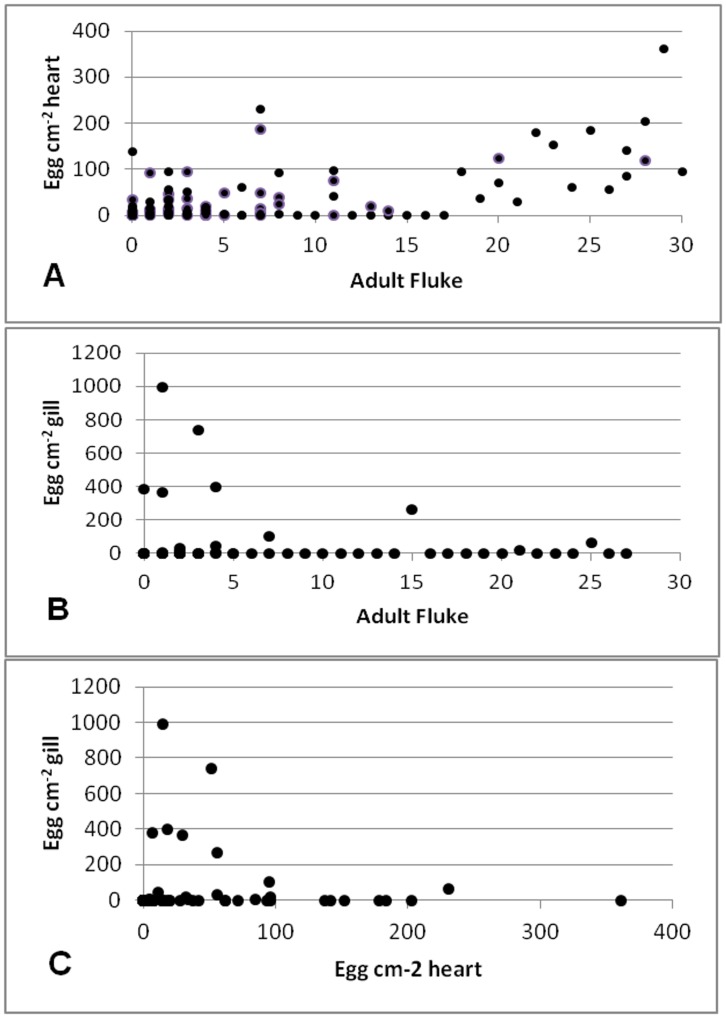
Correlation between (A) the number of adults and eggs in the heart, Spearman’s rho = 0.550, df = 184, p<0.001; (B) the number of adults and eggs in the gills, Spearman’s rho = −0.283, df = 175, p<0.001; (C) the number of eggs in the heart and eggs in the gills, Spearman’s rho = −0.387, df = 170, p<0.001 for Cohort2009A, Cohort2009B, and Cohort2010 combined.